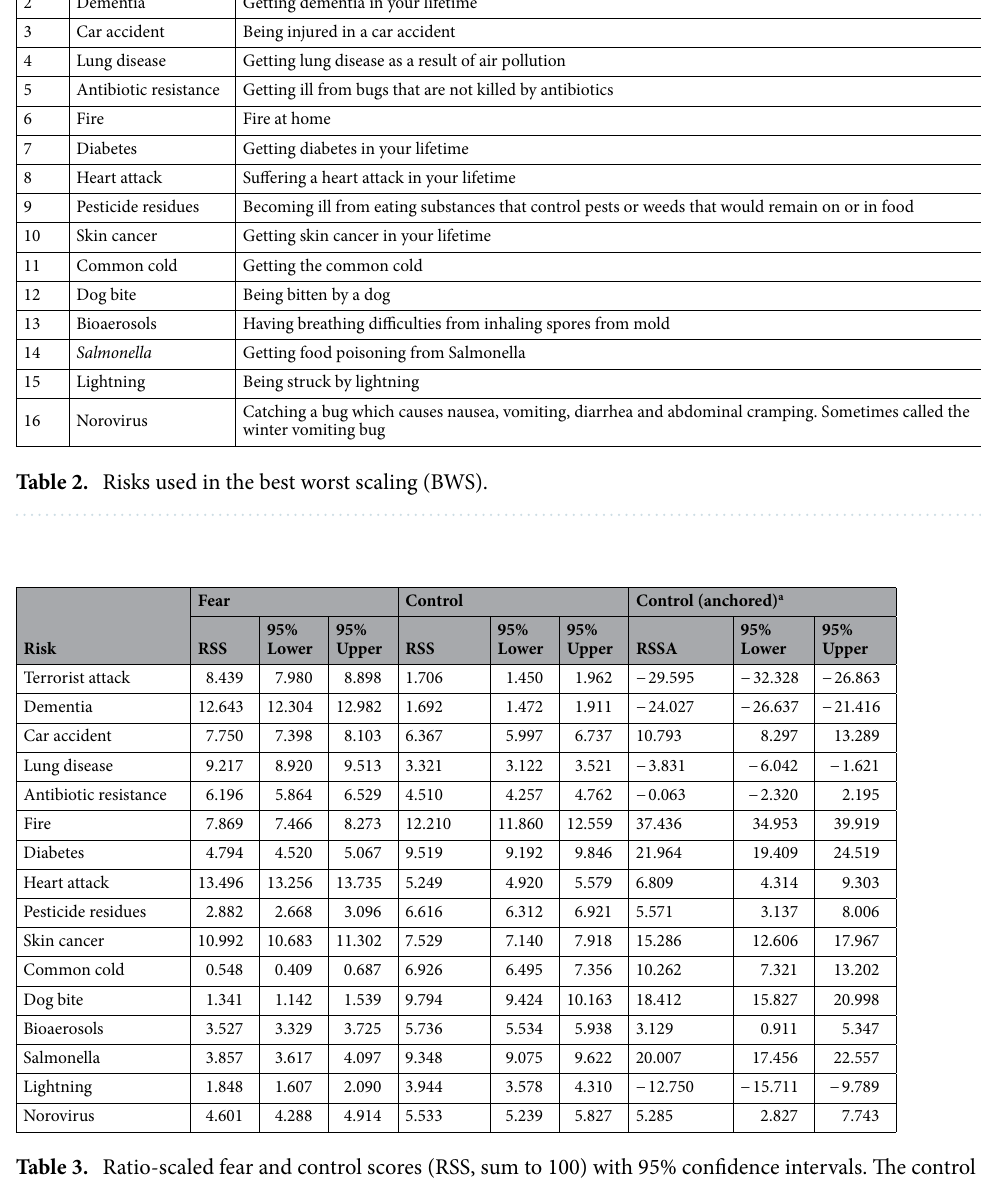
Table 3. Ratio-scaled fear and control scores (RSS, sum to 100) with 95% confidence intervals. The control scores are presented as unanchored (RSS) and anchored (RSSA) scores. a Zero = threshold for taking action to reduce the